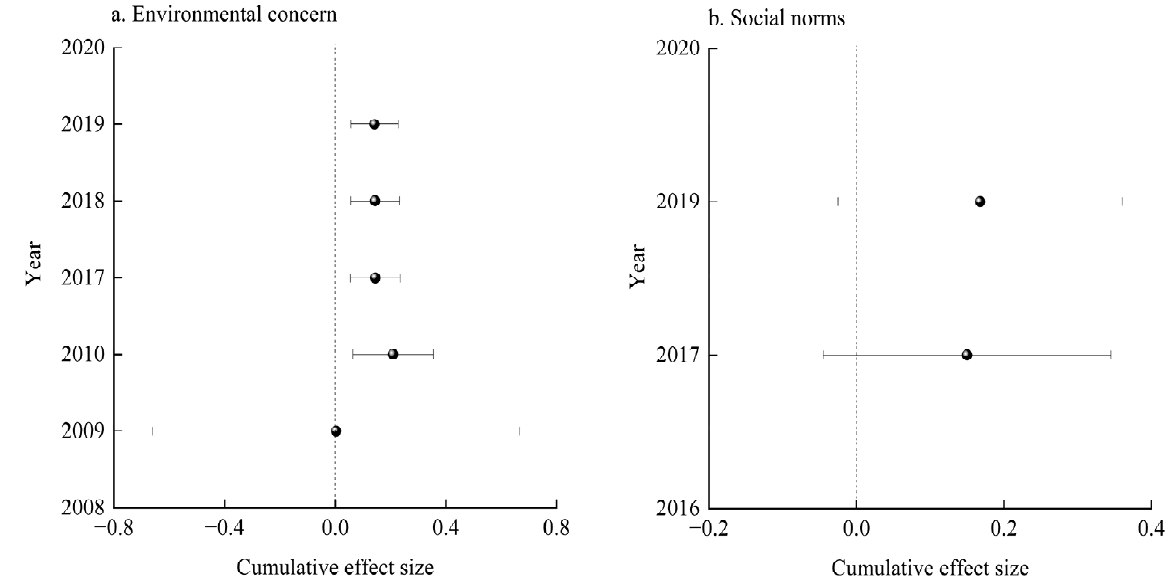
Figure 4. Cumulative meta-analysis trend (planting characteristics).